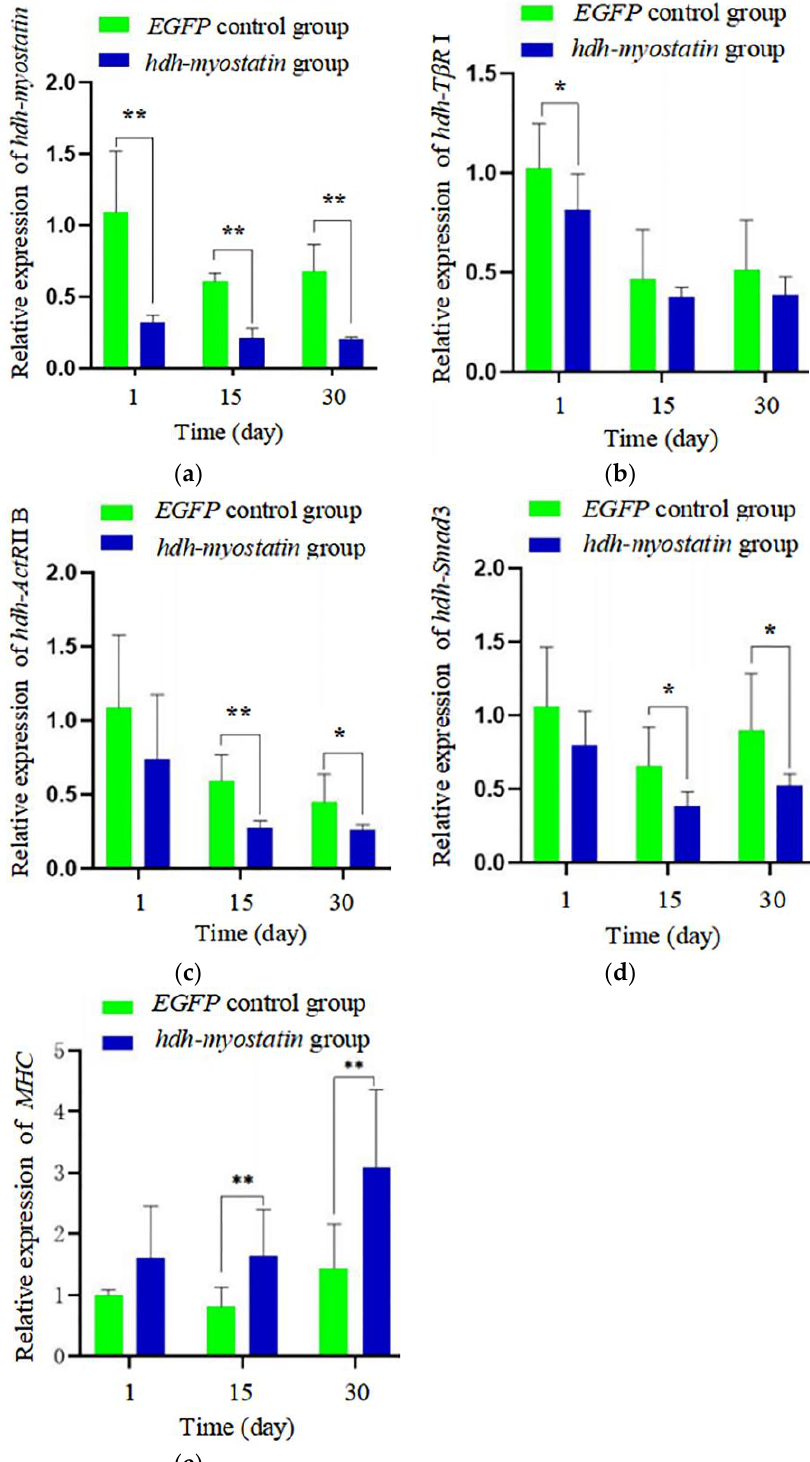
Figure 5. The results of qRT-PCR. ( a ) Relative expression level of hdh-myostatin after RNAi (RNA interference) in the cerebral ganglion. ( b ) Relative expression level of hdh- TβR I after RNAi in adductor muscle. ( c ) Relative expression level of hdh-ActR IIB after RNAi in adductor muscles. ( d ) Relative expression level of hdh-Smad 3 after RNAi in adductor muscle. ( e ) Relative expression level of MHC after RNAi in adductor muscles. The expression of target genes was normalized to the 18S rRNA and β -actin gene as the internal reference. These results are shown as mean values ± SD. Significant differences in gene expression levels are shown as ** p < 0.01 and * p < 0.05.